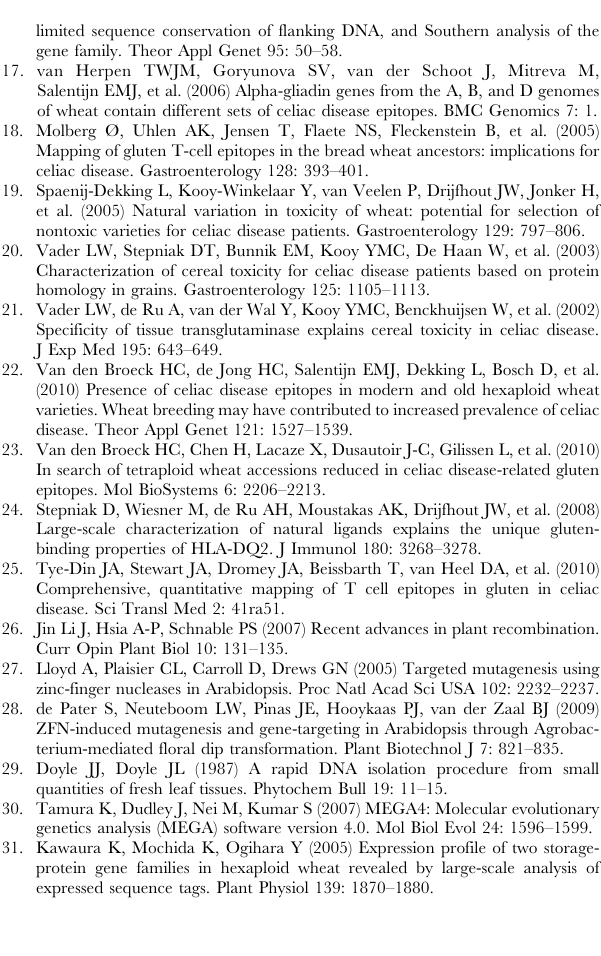
Table S2 The effects of proline to serine substitutions in an elongated version of the 33-mer, which also encodes the DQ2-Glia- a 3